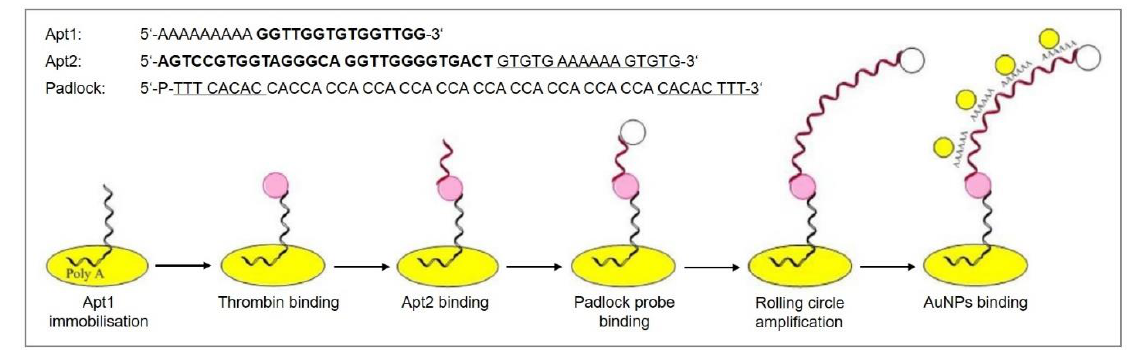
Figure 14. Stepwise fabrication of an aptasensor incorporating rolling circle amplification and gold nanoparticle binding for signal amplification. The DNA sequences are shown on top: Thrombin binding sites are pictured in bold, complementary bases underlined. Adapted with permission from the authors of [14], copyright 2018, Elsevier.